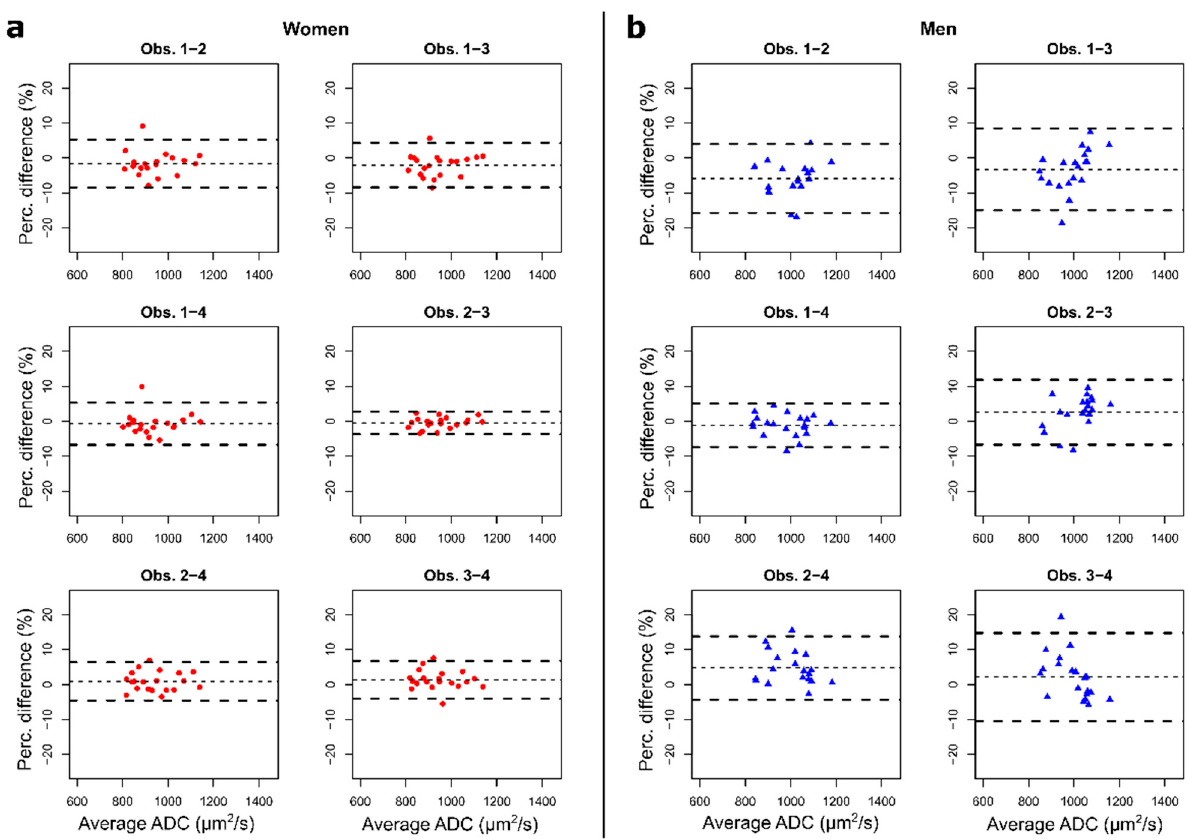
Figure 4. Bland-Altman plots of inter-observer mean apparent diffusion coefficient (ADC) measures of bone lesions. Each plot represents the percentage difference between the measures of a pair of observers compared to the average of their measures in the second reading session. In our cohort, ( a ) excellent reproducibility was observed in women with breast cancer, with bias and 95% limits of agreement below ±2.5% and ±8.5%, respectively. ( b ) Higher variability was observed in men with prostate cancer, with bias and 95% limits of agreement below ±6% and ±16%, respectively.